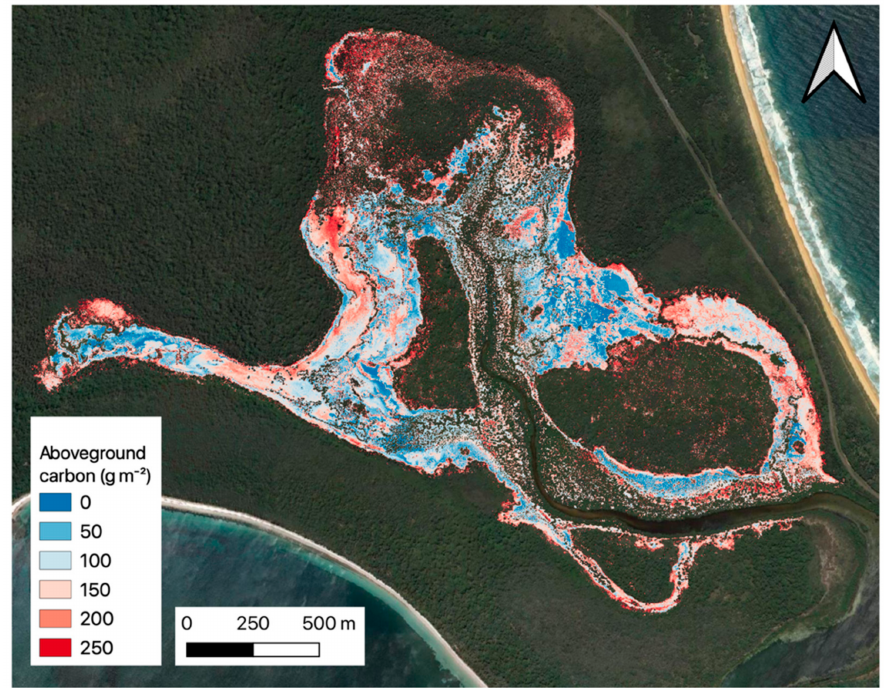
Figure 5. Spatial distribution of aboveground carbon content in Saltmarsh derived from the Arbor- Cam NDVI image calibrated using the herbs, grasses, and sedges simple linear regression